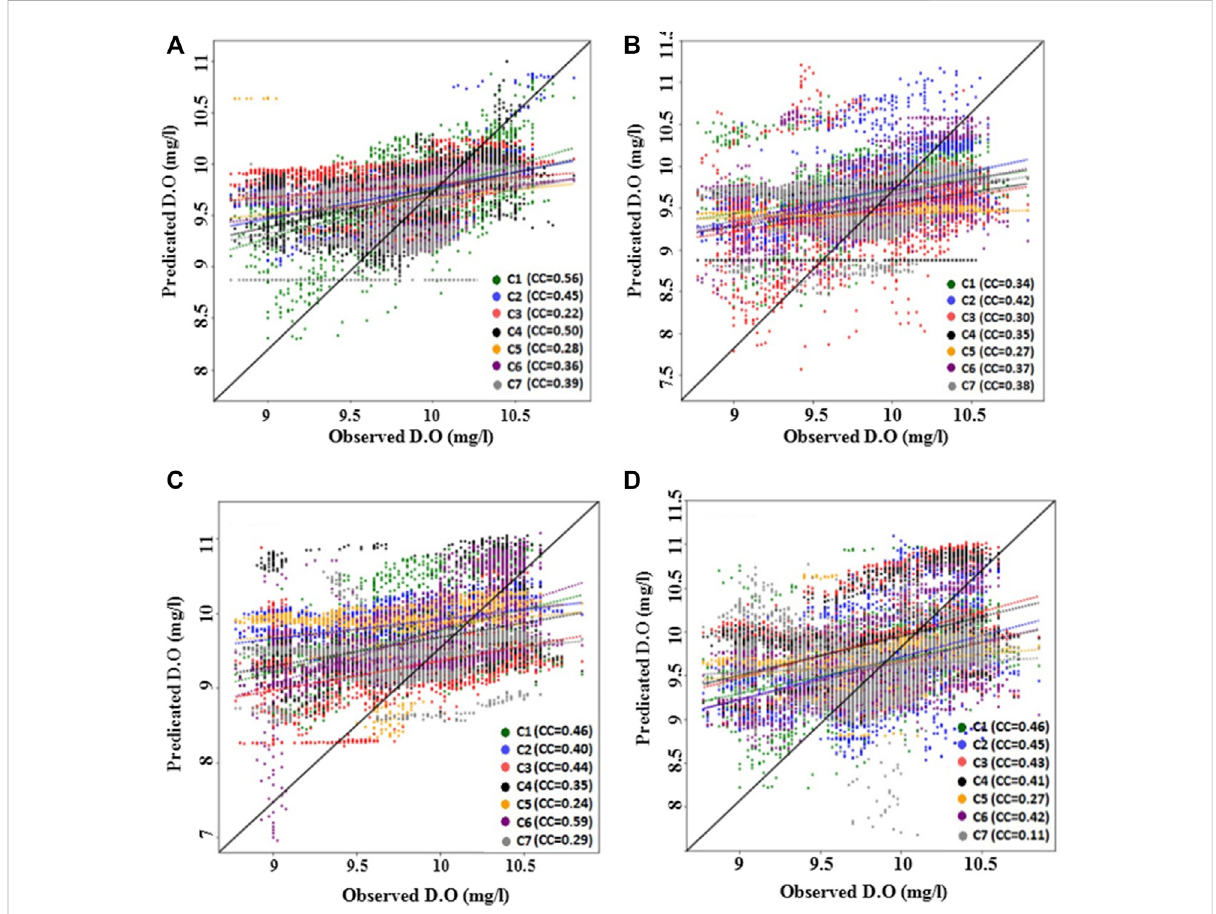
FIGURE 8 Scatterplotofobservedandpredicteddissolvedoxygenby (A) NF-GWO; (B) NF; (C) NF-SC;and (D) NF-FCMmodelsduringthetestingphaseat